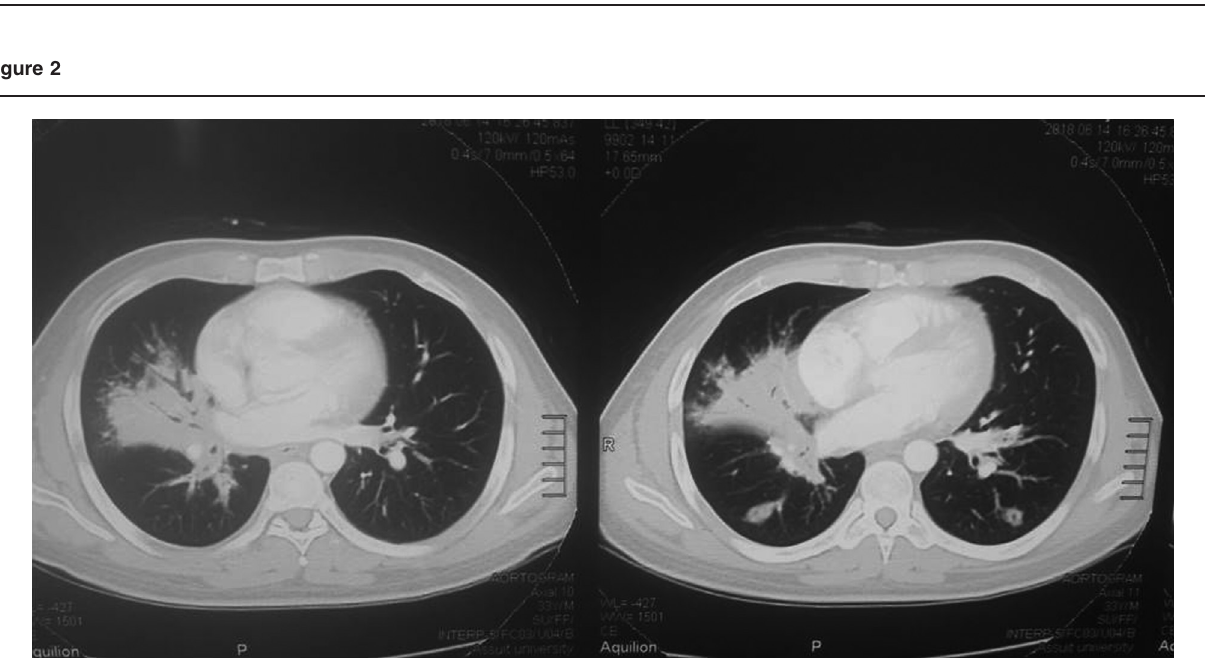
Computed tomography